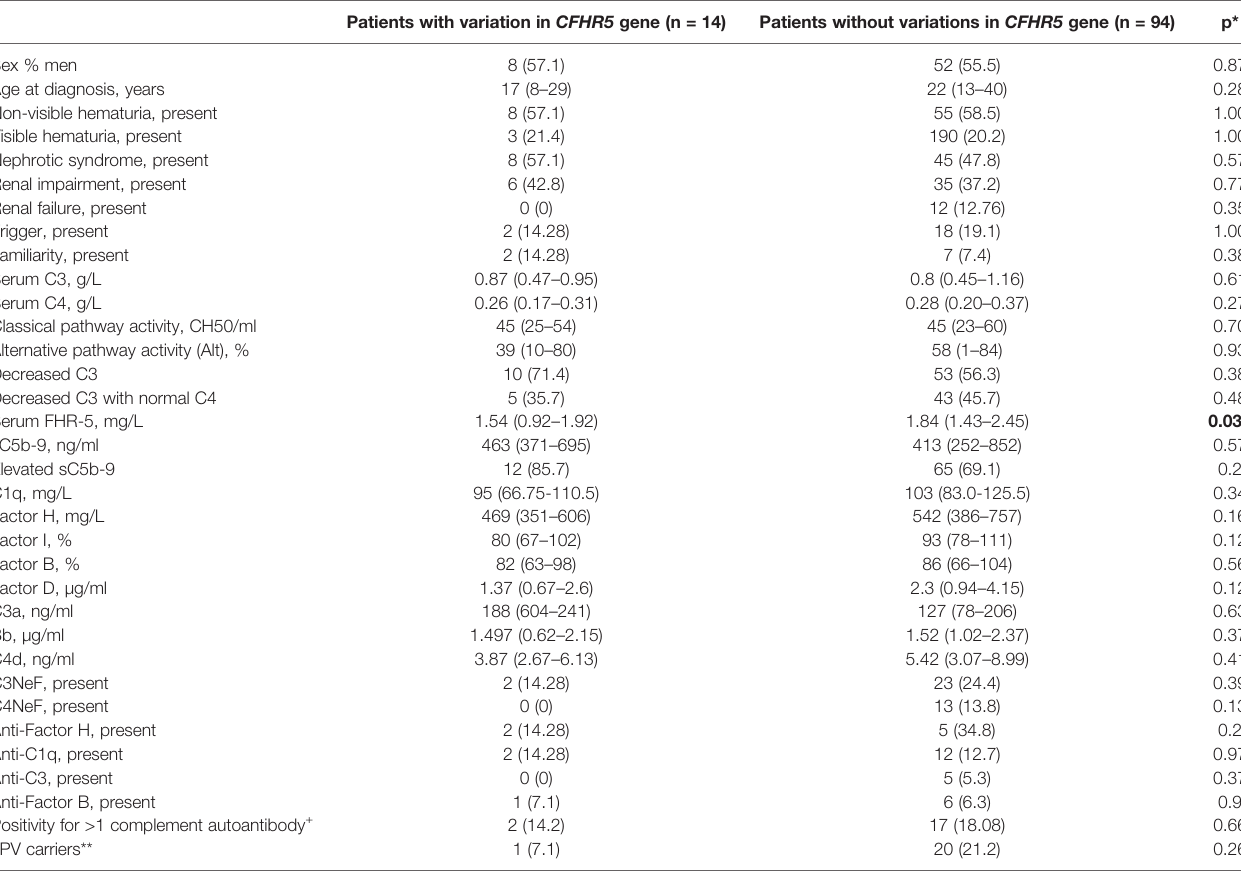
TABLE 2 | Clinical characteristics of patients with or without CFHR5 variations. Patients with variation in CFHR5 gene (n = 14) Patients without variations in CFHR5 gene (n =